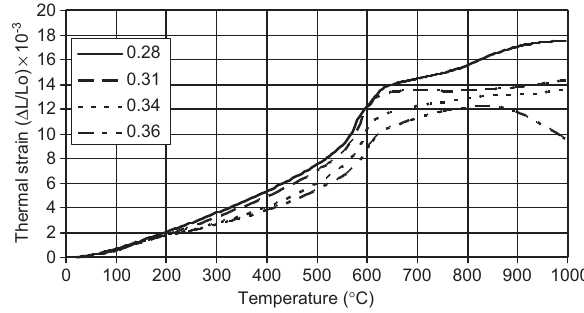
Figure 5 Thermal strain ratios of SCC vs. temperature.